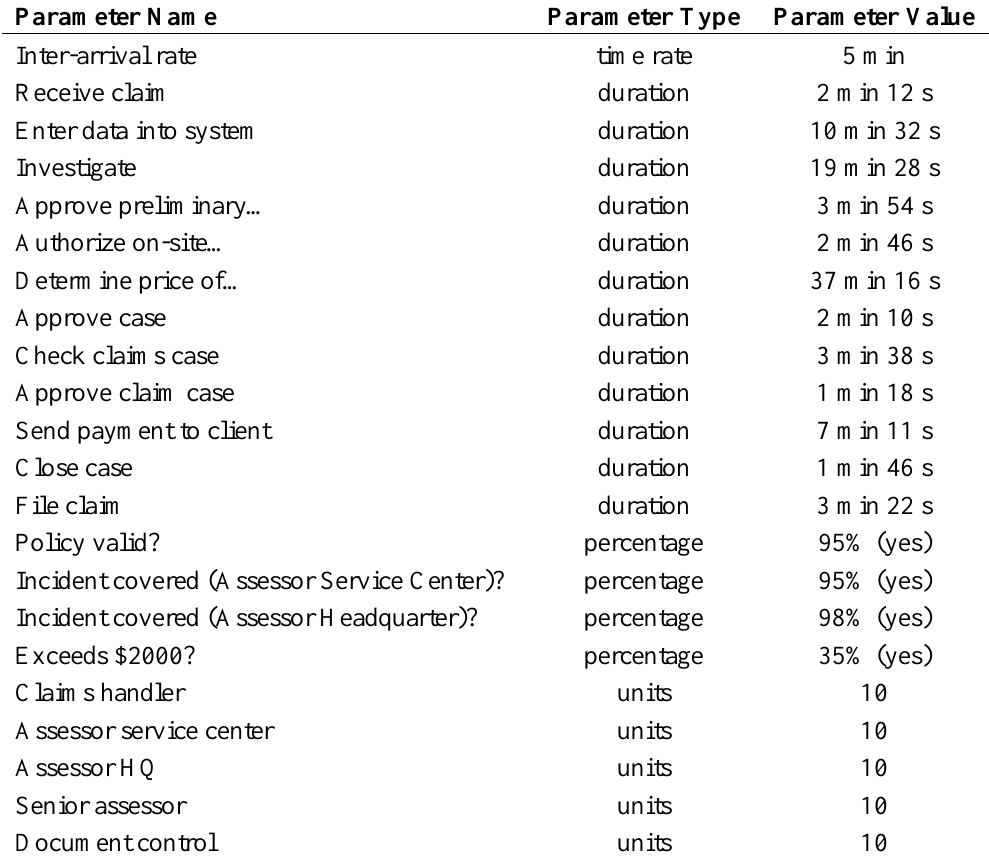
Table 14. Parameter and their values for the insurance scenario.